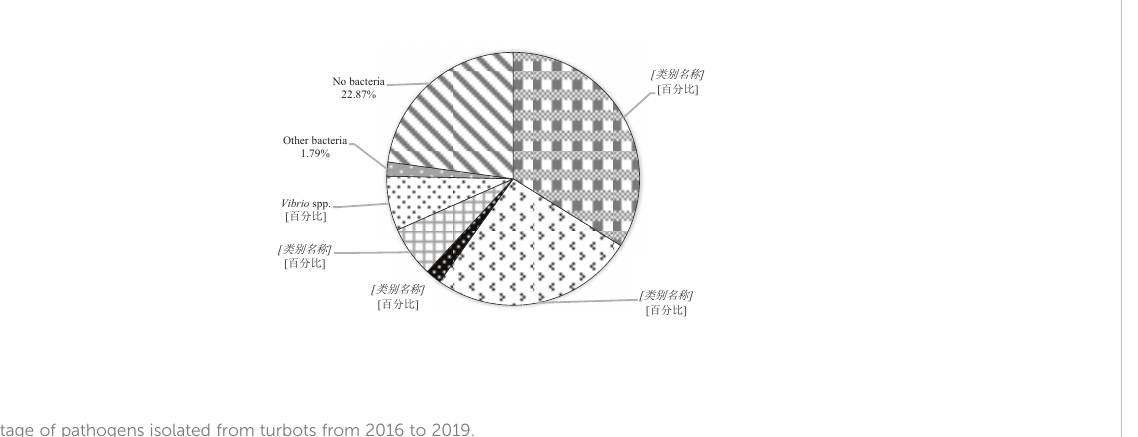
FIGURE 3 The percentage of pathogens isolated from turbots from 2016 to